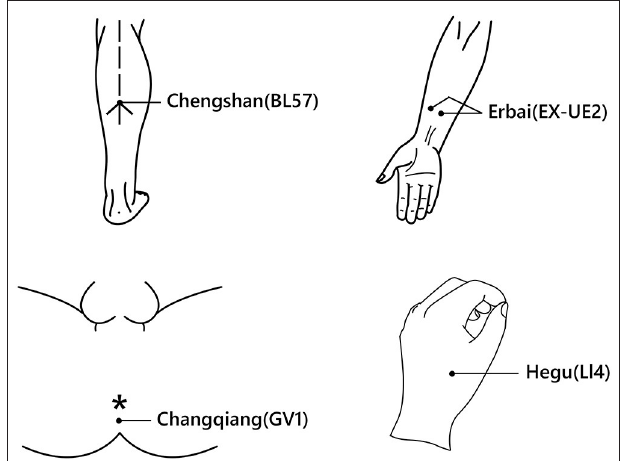
FIGURE 4 | The four most frequently used acupoints. Chengshan (BL57): A point on the Bladder Meridian of Foot-Taiyang, below the juncture of the belly on both sides of the gastrocnemius muscle, on the back of the shank and in the depression formed when the ankle joint stretches out. Erbai (EX-UE2): One point of the Extra Points, on the palmar aspect of the forearm, 4 cun proximal to the transverse crease of the wrist, on each side of the radial flexor muscle tendon of the wrist. Changqiang (GV1): A point on the Governor Vessel, below the tip of the coccyx, at the midway between the tip of the coccyx and the anus. Hegu (LI4): A point on the Large Intestine Meridian of Hand-Taiying, on the dorsum of the hand, between the first and second metacarpal bones, at the middle of the radial side of the second metacarpal bone (31). The picture was drawn and authorized by Biqing Zou. The *demonstrates anus in the figure.